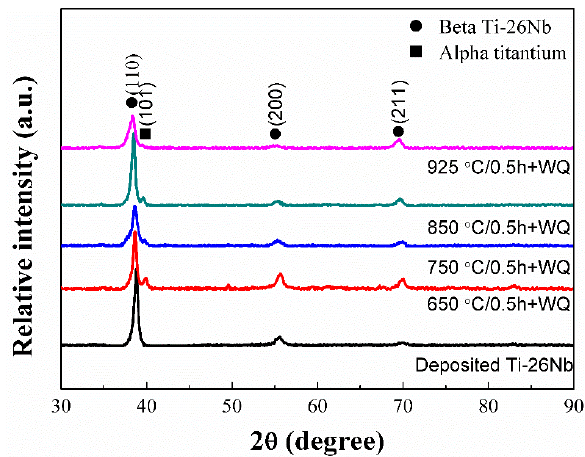
Figure 4. X-ray diffraction (XRD) patterns of LAM-processed Ti–26Nb alloys after annealing treatment at different temperatures.